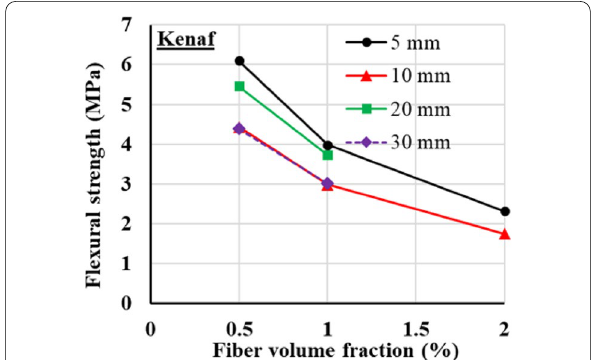
Fig. 17 Effect of kenaf fibers on flexural strength